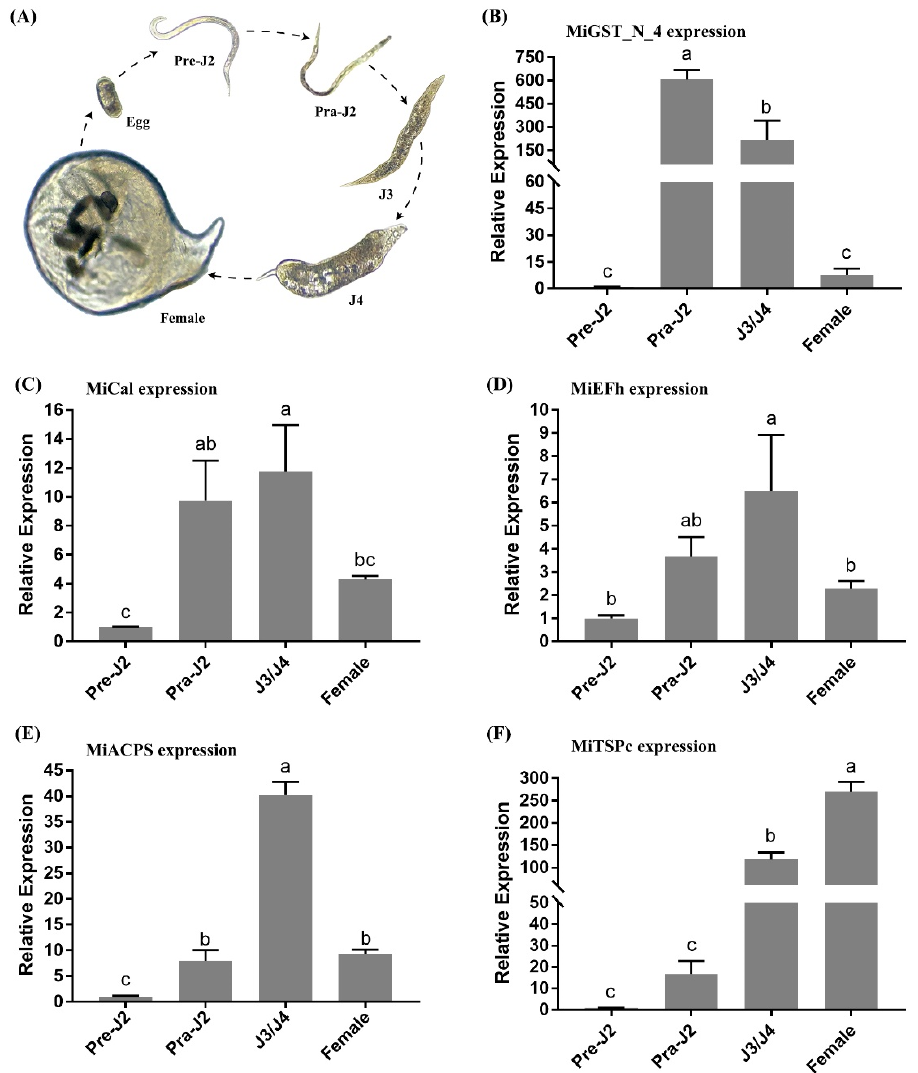
Figure 5. Developmental expression of the five effectors of M. incognita . ( A ) The growth cycle of M. incognita . “Egg” indicates eggs obtained from gall masses; “Pre ‐ J2” indicates newly hatched pre ‐ parasitic second ‐ stage juveniles M. incognita from eggs; “Pra ‐ J2” indicates parasitic second ‐ stage juveniles collected from the RKN ‐ susceptible tobacco variety W38 after inoculated with Pre ‐ J2 M. incognita for 7 days; “J3/J4” indicates parasitic third ‐ stage juveniles (J3)/ parasitic fourth ‐ stage juveniles (J4) collected from the RKN ‐ susceptible tobacco variety W38 after inoculated with Pre ‐ J2 M. incognita 14 days to 21 days. Female indicates female M. incognita isolated from tobacco roots after 30 days of inoculation with Pre ‐ J2 M. incognita . ( B – F ) Life stage expression of the five effectors. The relative expression levels of MiGST_N_4 , MiCal , MiEFh , MiACPS , and MiTSPc were quantified using quantitative RT ‐ qPCR of four different M. incognita life stages: pre ‐ J2, pra ‐ J2, J3/J4, and female. The actin gene was used as a reference gene. The values were calculated using the 2 − △△ Ct method and presented as the fold ‐ change in mRNA level in various nematode developmental stages relative to that of pre ‐ J2. Means ± SD were shown. The results shown are representative of at least three independent experiments. Different letters indicate significant differences based on one ‐ way analysis of variance (ANOVA) followed by Duncan’s multiple range test ( p < 0.05).